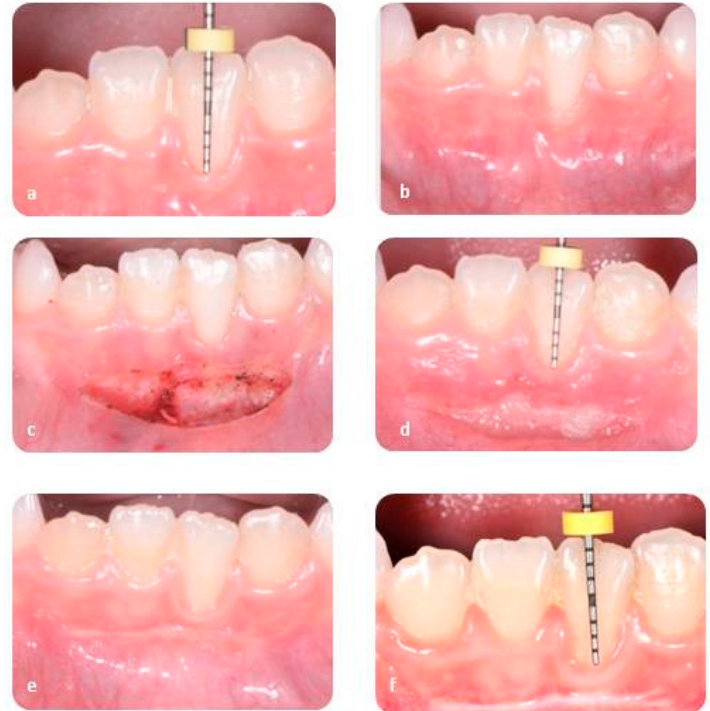
Figure 1. Diode laser: pre ‐ operative evaluation ( a,b ), surgical wound ( c ), follow ‐ up after seven days ( d ), follow ‐ up afeter thirty days ( e ), follow ‐ up after six months ( f ).